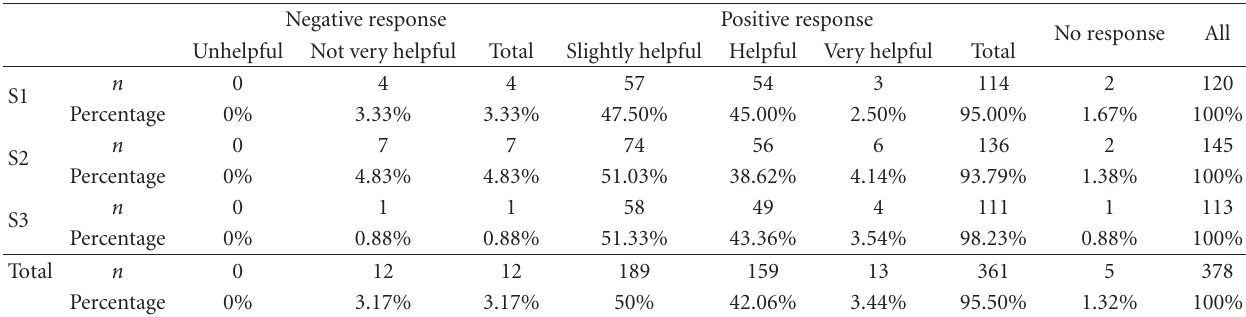
Table 4: Degree of perceived helpfulness of the curriculum to the student perceived by the program implementers.